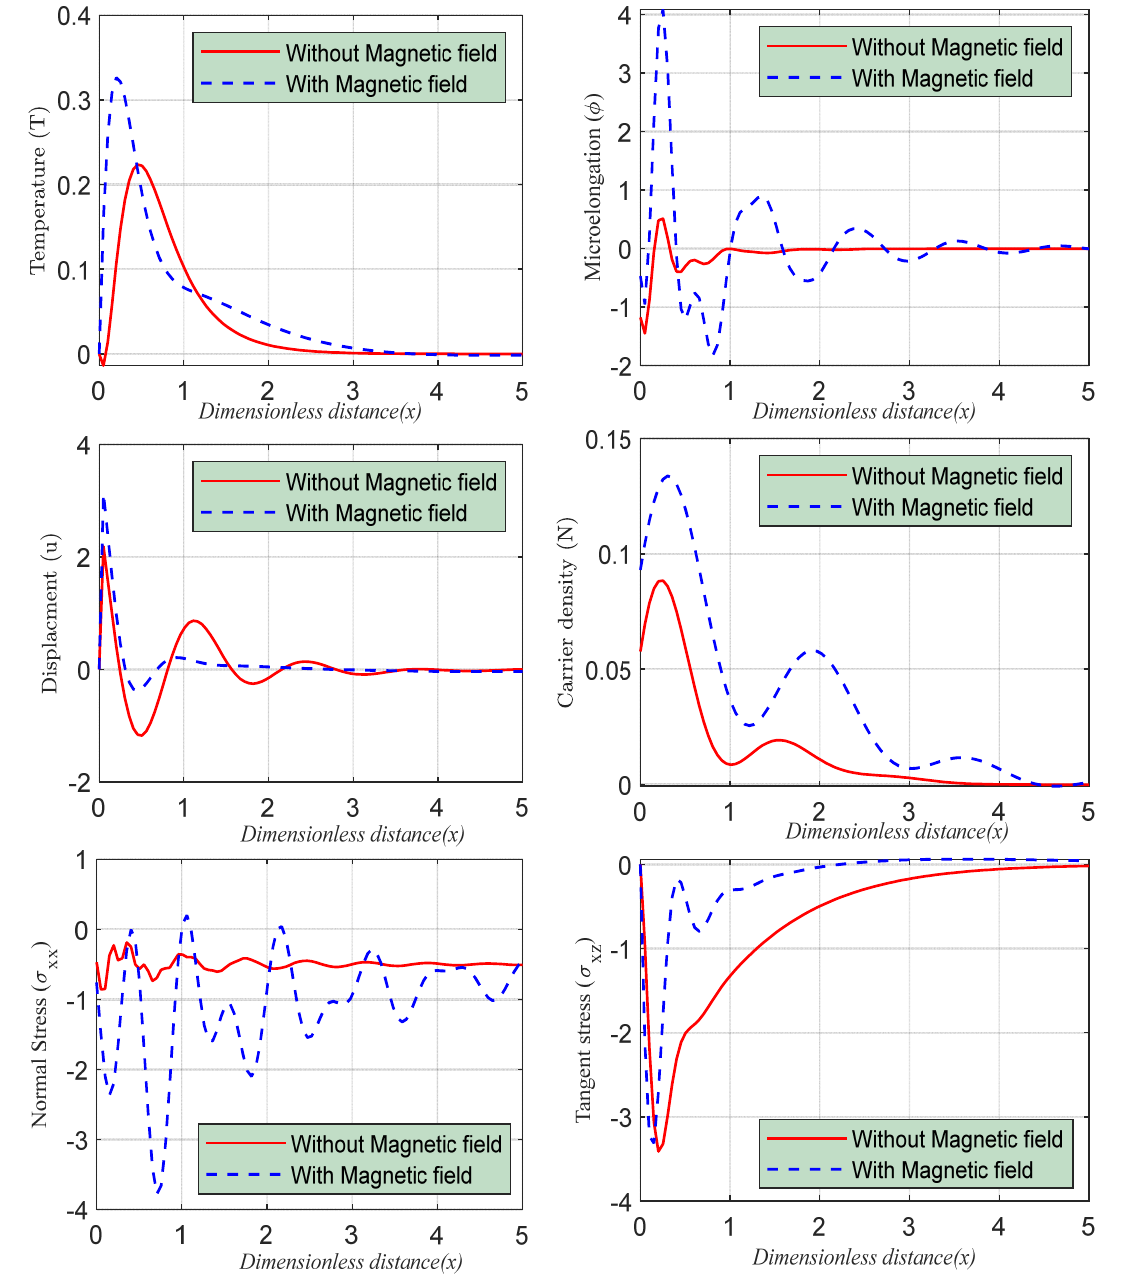
Figure 4. The wave propagations of the physical fields with the horizontal axial according to GL model under the influence of microelongation parameters in the presence of magnetic field and without magnetic field.